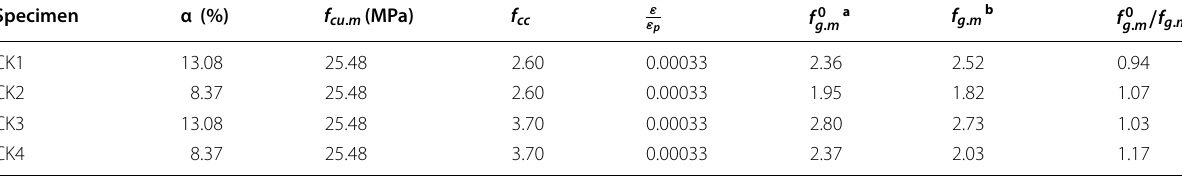
Table 5 Comparison of measured values to compressive strength with formula values (MPa). Specimen